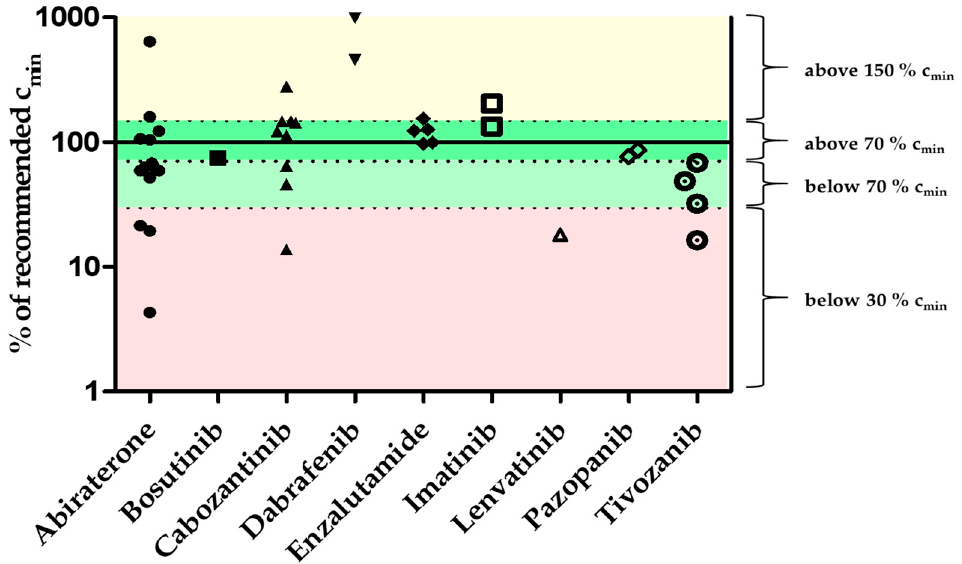
Figure 3. Overview of measured oral antitumor drug concentrations in patient plasma samples collected ± 4 h of trough level. The percentages of the plasma concentrations were calculated using the respective c min value (equivalent to 100%). Colored areas indicate whether the sample is below 30% (red), below 70% (light green), above 70% (green), or above 150% (yellow) of the respective c min value.